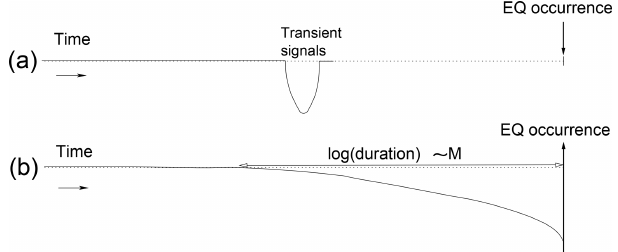
Figure 1. Schematic diagram showing the two distinct approaches proposed for a precursory behavior. (a) The case of the physical model for SES generation, which differs greatly from other sug- gested mechanisms (Rikitake, 1981) in which the anomalous pre- cursory behavior becomes more intense upon approaching the EQ occurrence (b) .